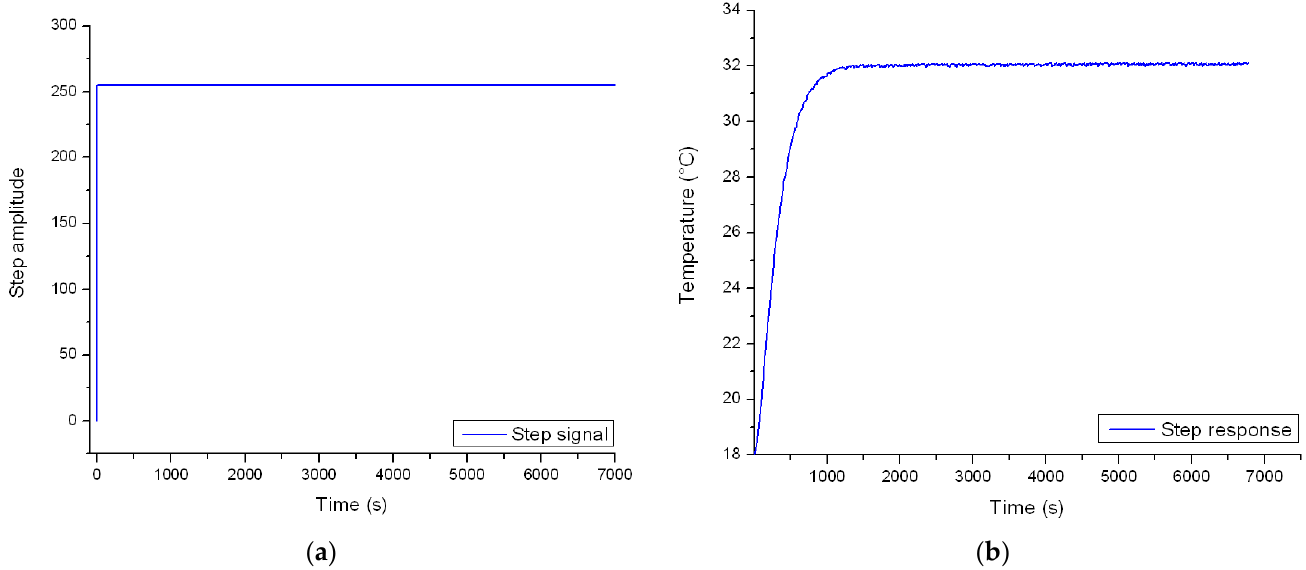
Figure 10. ( a ) Step input PWM signal and ( b ) output response temperature. Afterwards, the time constant and temperature gain of the resulting curve are